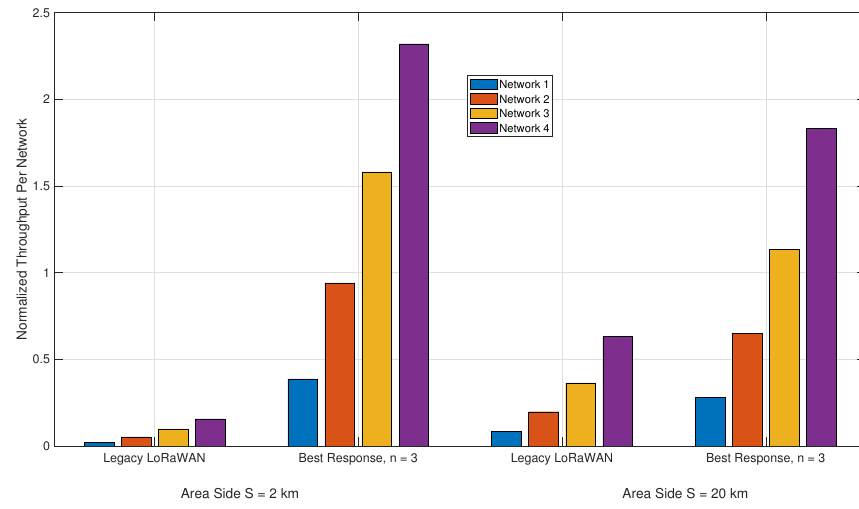
Figure 9. Normalized throughput per network as a function of S